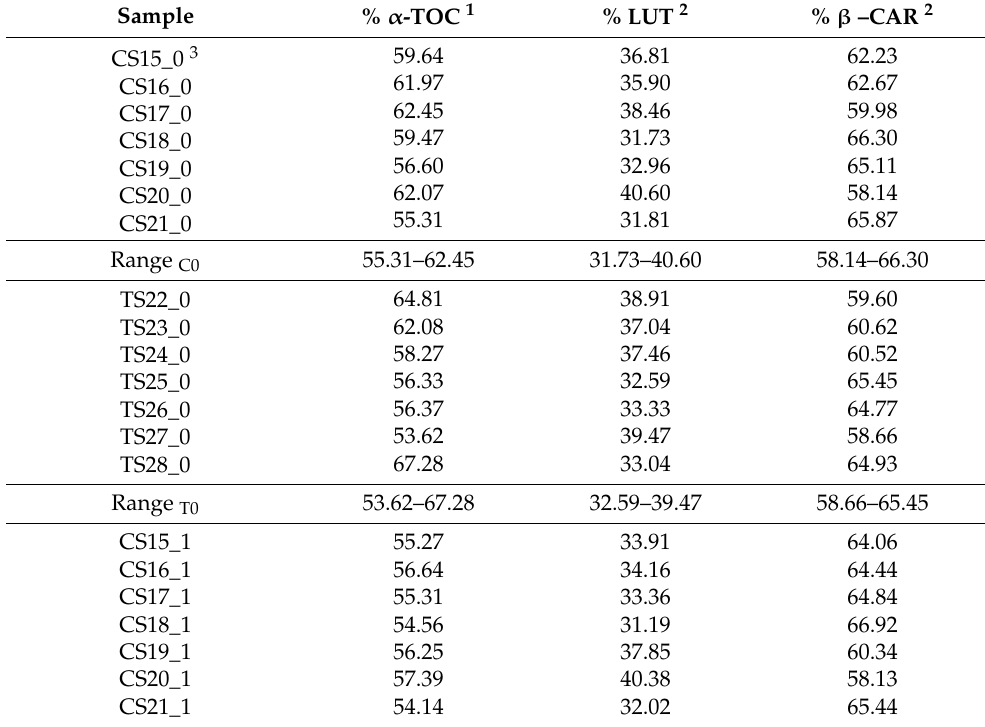
animal, and the fourth figure indicates whether the cheese is produced before (0) or after (1) the studied pasture. Table A2. Percentage of the most representative compounds in “Ragusano” cheeses produced in